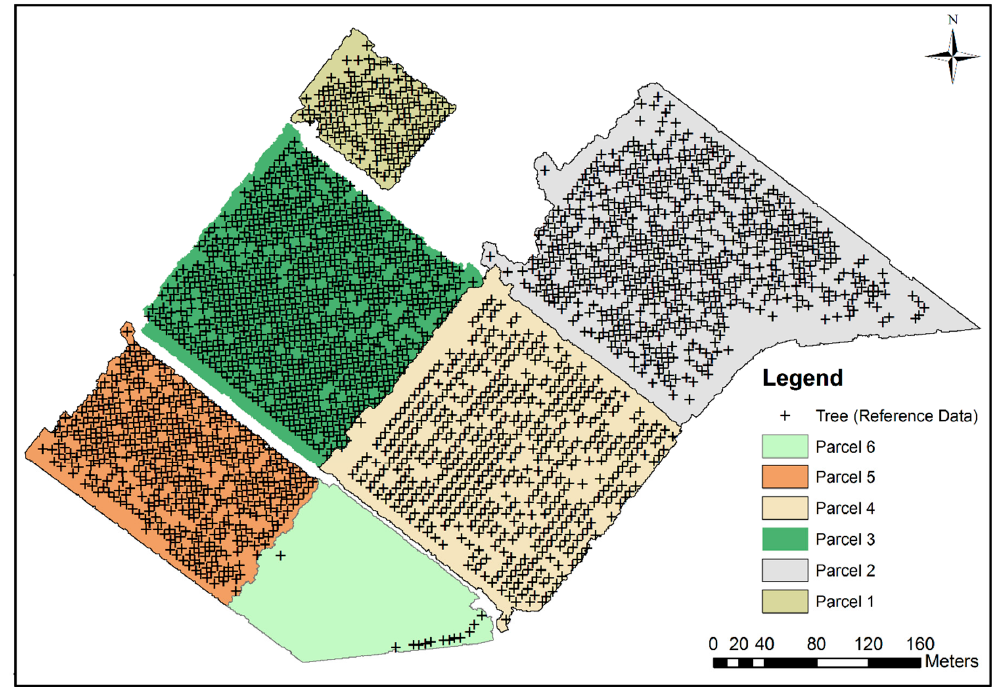
Figure 5. Reference map for the trees over the parcels of the study area.